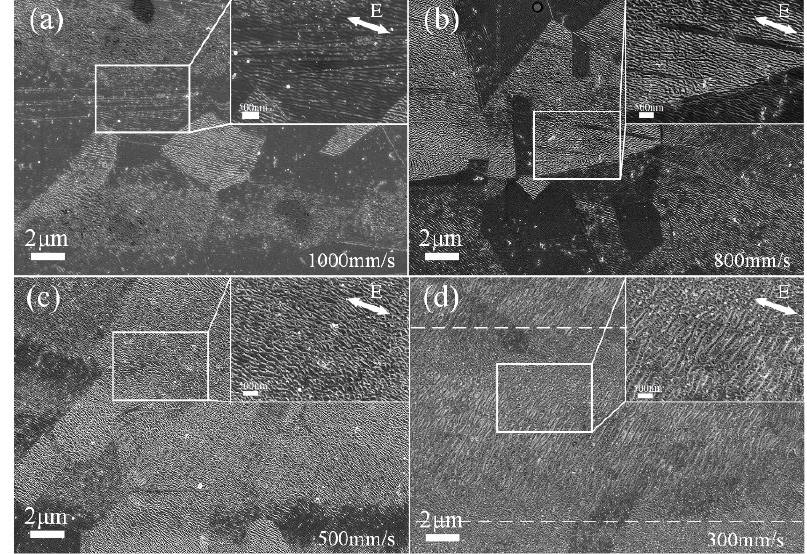
Figure 8. SEM images of subwavelength ripples prepared by different laser scanning speed and the fixed line spacing of 10 μ m. The laser scanning speed is set to ( a ) 1000 mm/s, ( b ) 800 mm/s, ( c ) 500 mm/s, and ( d ) 300 mm/s, respectively. The insets are zoomed views of the selected areas. The polarization of the incident laser is indicated by the white double-headed arrow.